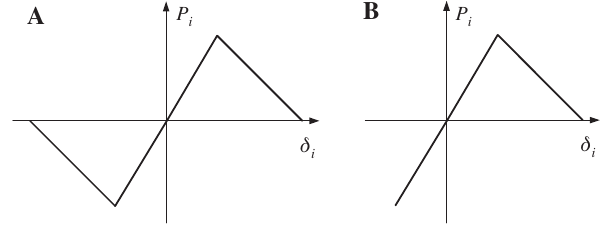
Figure 9: Bonding layer simplified bilinear model. (A) Shear